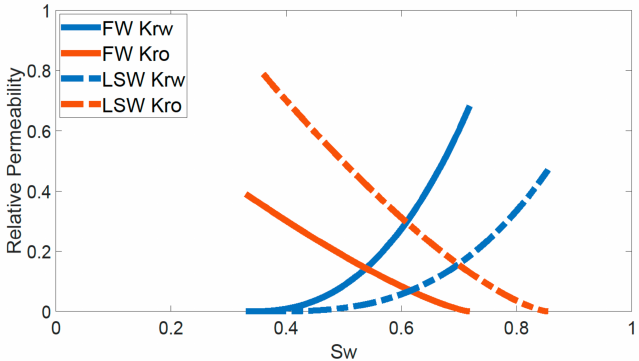
Figure 12. FW and low salinity waterflooding (LSW) extracted relative